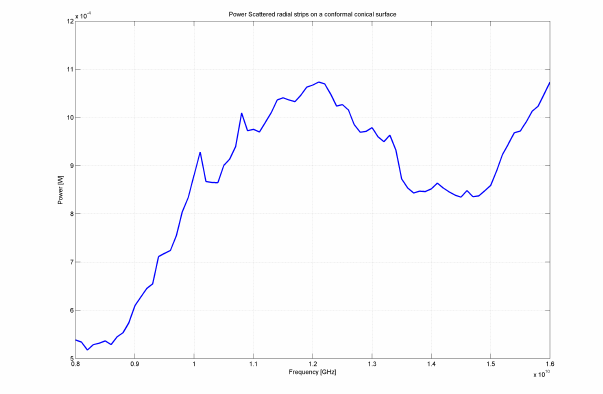
Fig. 17. Total scattered power for a plane wave